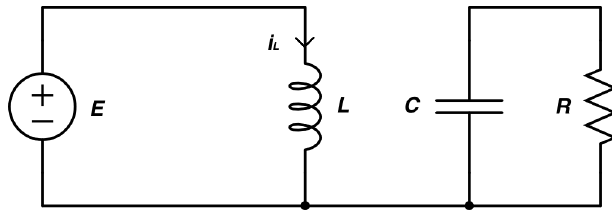
Figure 8. Buck-boost converter—switch “ON”.